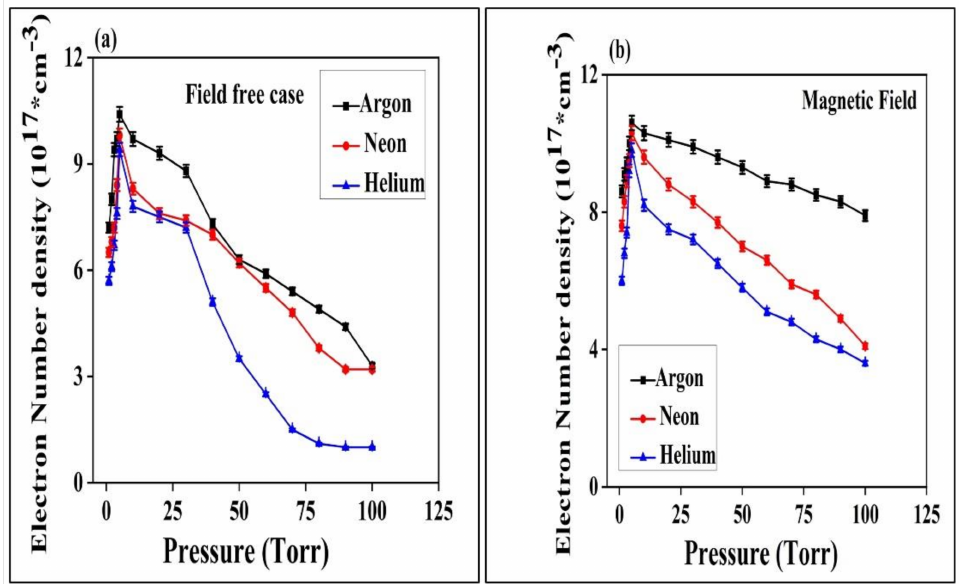
Figure 5. The variation in n e of laser-induced Mg alloy plasma at various pressures under Ar, Ne, and He environments at an irradiance of 2.0 GW/cm 2 in the absence ( a ) and presence ( b ) of